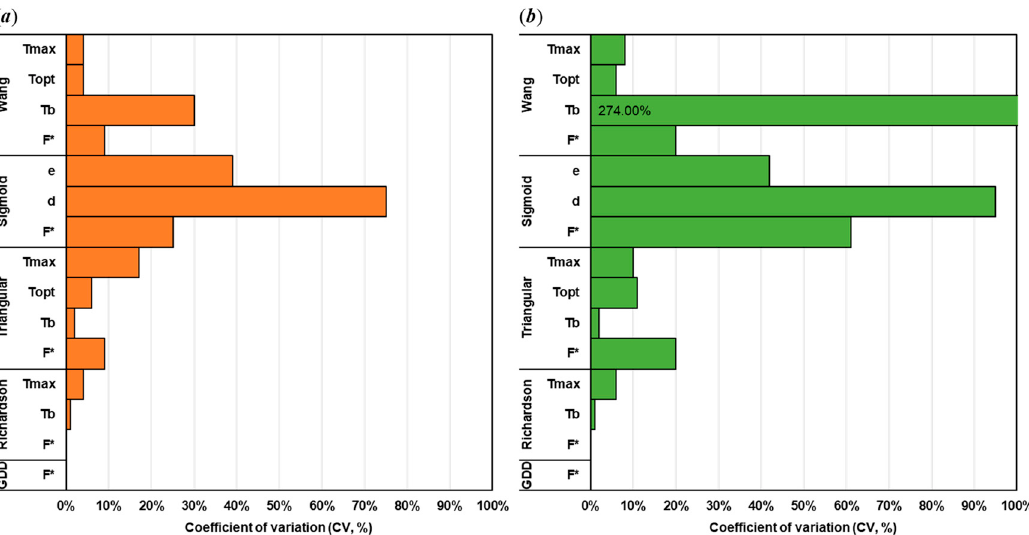
Figure 4. Coefficient of variation (CV, %) for obtained optimal parameter values among the three applied algorithms for ( a ) Touriga Franca (TF) and ( b ) Touriga Nacional (TN). These are obtained with the expanded lower and upper boundary of parameter distribution by 100%, relative to the baseline settings. The obtained individual parameter values are presented in Table S2. Note that the CV value for T b parameter of the Wang model in TN is denoted as it exceeds 100%.